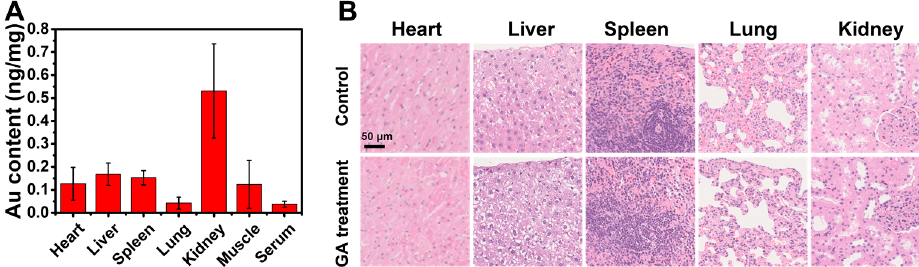
Figure 7. In vivo biodistribution of Au ( A ) and histopathological examination (scale bar = 50 µm, 40×) of major organs ( B ) after continuous topical treatment with GA (5 mg/kg Au) on the back of mice once a day for 7 days. The Au content was determined by ICP-MS, and the data are presented as mean ± SD of three mice.